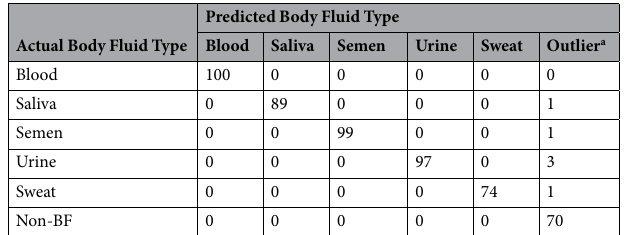
Table 1. Discrimination results for the ATR FT-IR spectra of fresh BFs and unexpected samples using the five-class PLS-LDA model followed by Q-tests for each BF group validated. a Q-tests for each BF group were implemented with a statistical significance level of 99.5%.